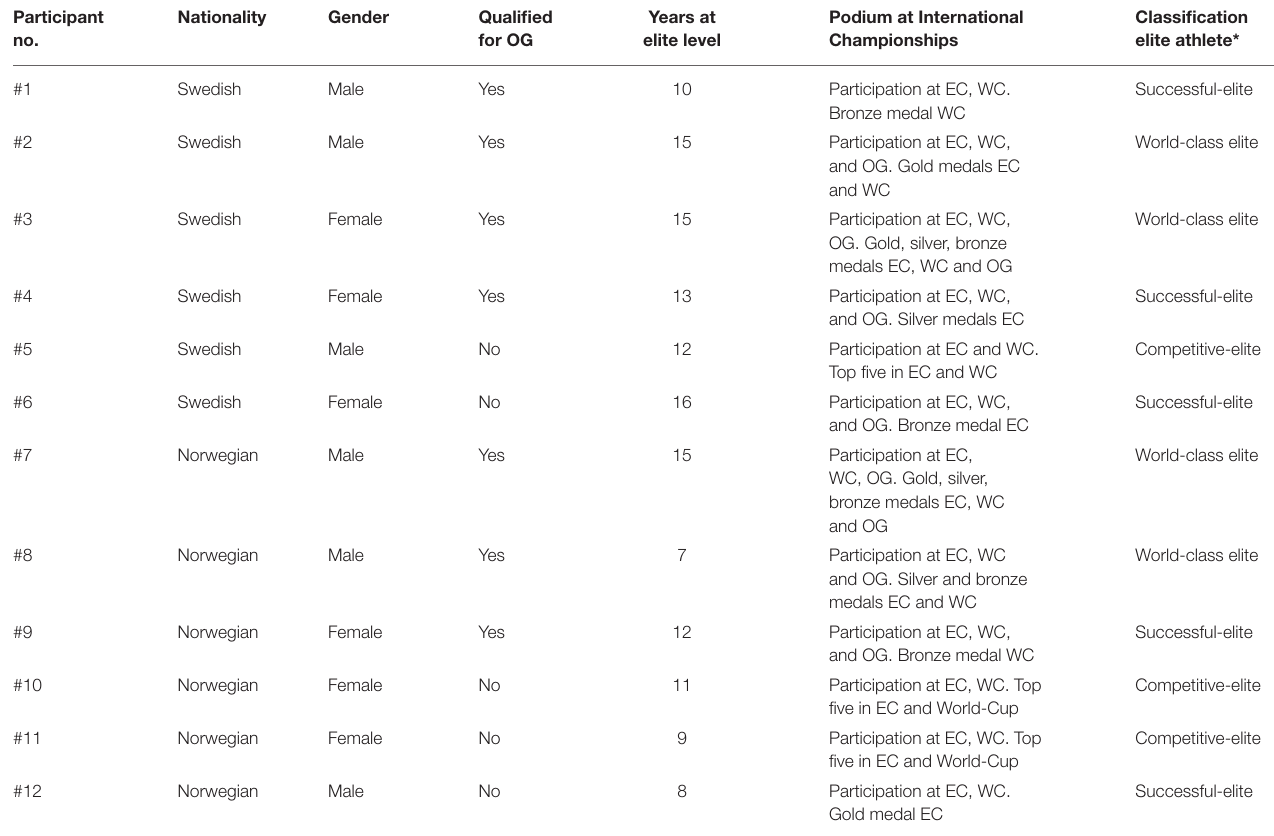
TABLE 1 | Descriptions of the 12 elite athletes’ sports levels and merits. Participant no.